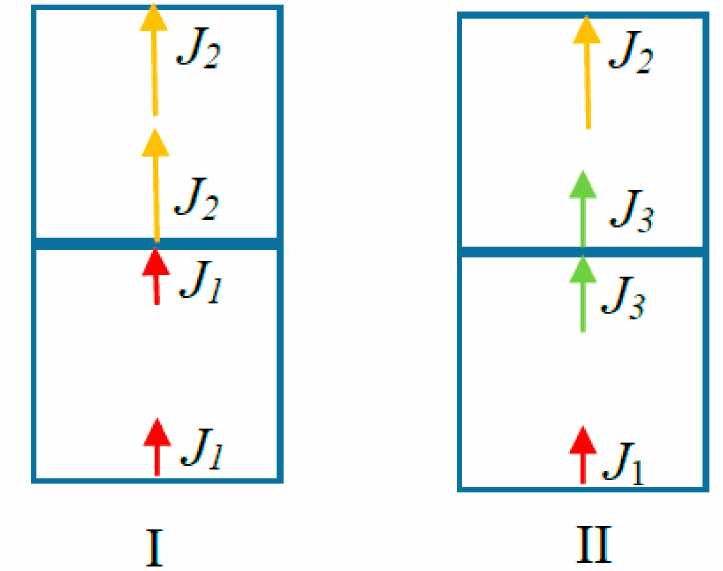
Figure 1. The di ff erence between the two procedures to evaluate the electromagnetic fields using the field expressions for accelerating and moving charges. In procedure I, the changes of current and velocity take place at the boundary of the two elements, while they remain constant within each volume. In this procedure, charges accumulate at the boundary of the two elements if the current changes in space. In procedure II, the current and velocity change as they pass through the element but remain continuous at the boundary. Thus, no charges accumulate at the